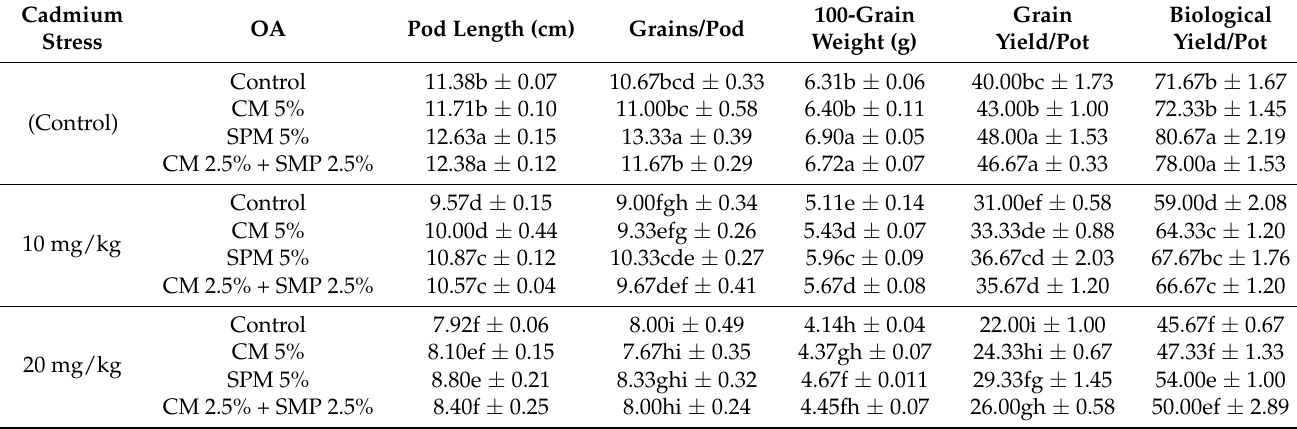
Table 2. Effect of different organic amendments on yield attributes of mash bean grown under different levels of Cd stress. Cadmium OA Stress